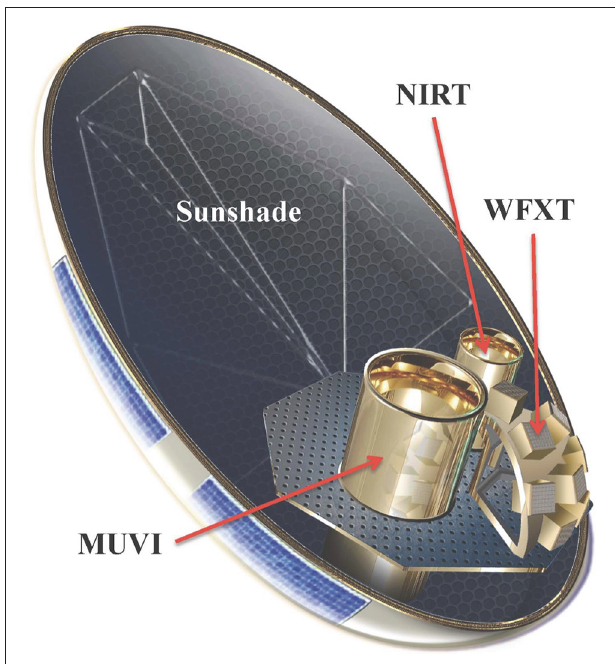
FIGURE 10 | ATO observatory layout. The eight WFXT modules, NIRT, and MUVI are highlighted. The sunshade is also highlighted.